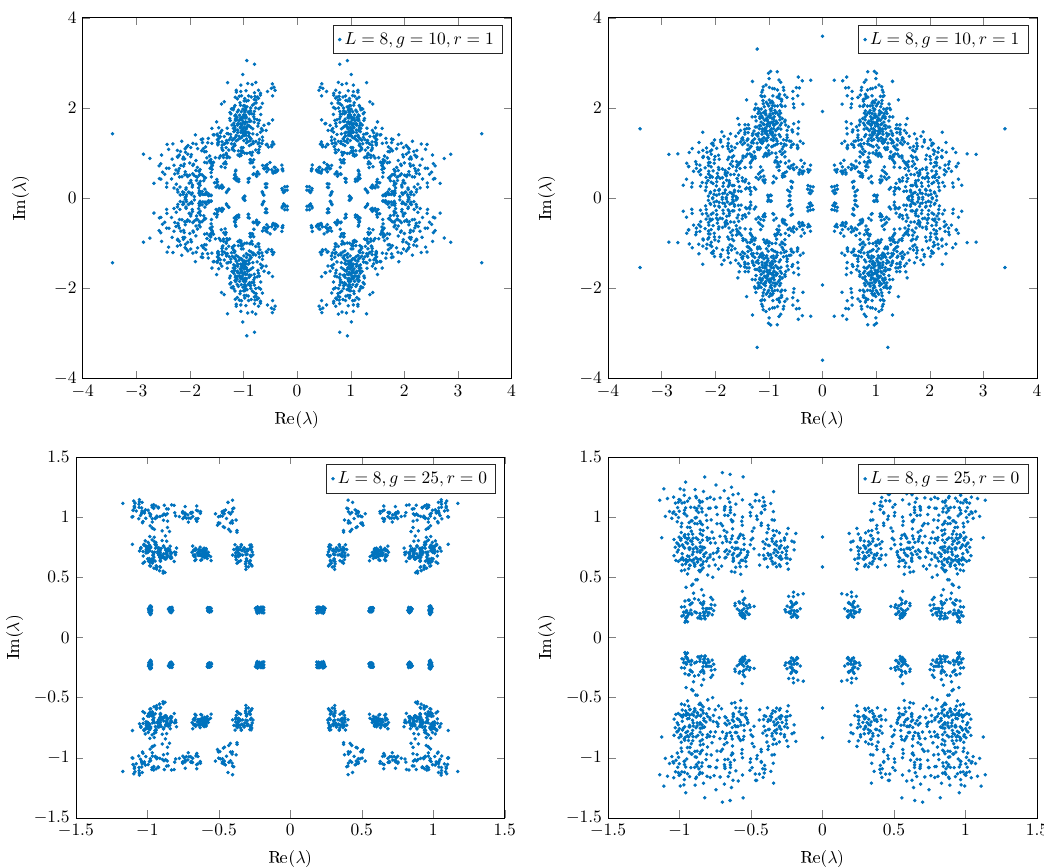
Figure 1 . Spectrum of ^ O F , in absence (left diagrams) and presence (right diagrams) of A (Yukawa- like)